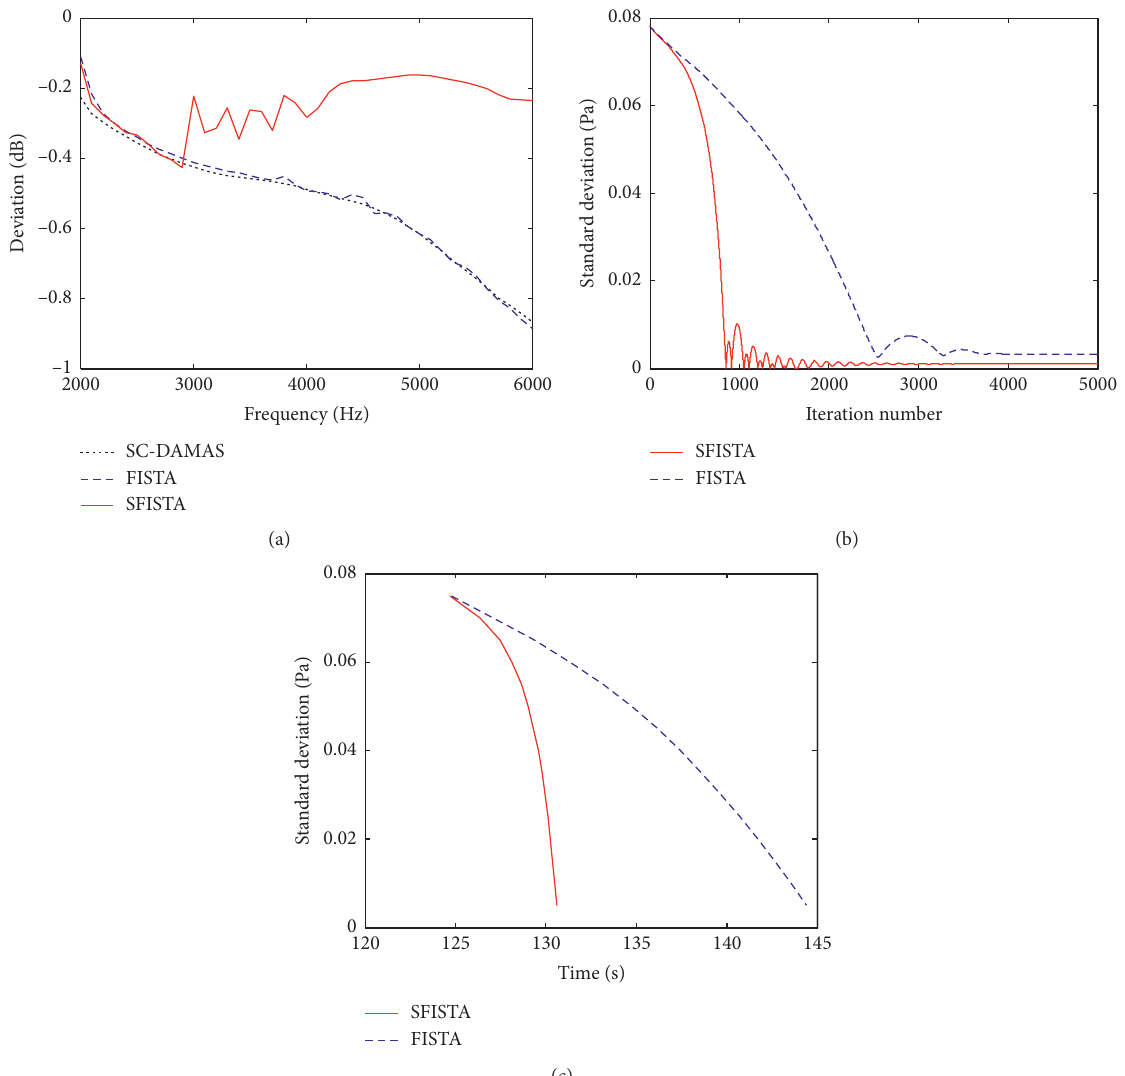
Figure 6: Performance comparison. (a) Amplitude deviation; (b) convergence; (c) computational and different frequencies. The location error is measured by the ratio of the distance between the identified position of the maximum SPL and the preset sound source position to the grid spacing. The quantification error of strength is measured by the deviation between the mainlobe integral of the identified sound source and the preset 100 dB. The black dot dash line and blue dotted line are the results of 2000 Hz and 6000 Hz at 20 dB SNR, and the red solid line and green solid line are the results of 2000 Hz and 6000 Hz at 40 dB SNR. Figure 7(a) is the CDF of the location error, and in general, the location accuracy of 6000 Hz is higher than that of 2000 Hz, and the accuracy is higher in the case of 40 dB SNR than that of 20 dB SNR. Except that there are a few points whose location error is greater than one grid interval in the case of 2000 Hz and 20 dB SNR, the location errors of other points are less than one grid interval, which indicates that almost all the identified sound source positions fall on